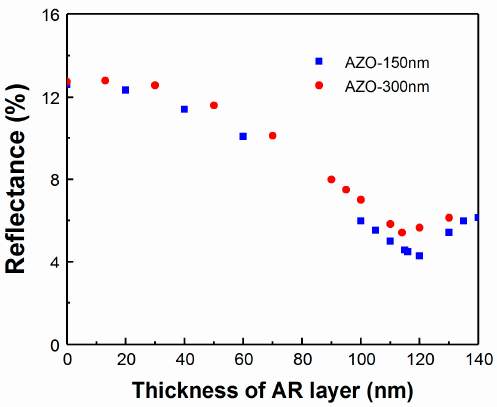
Figure 14. Real-time reflectance for CIGS devices with different AZO layer thickness.